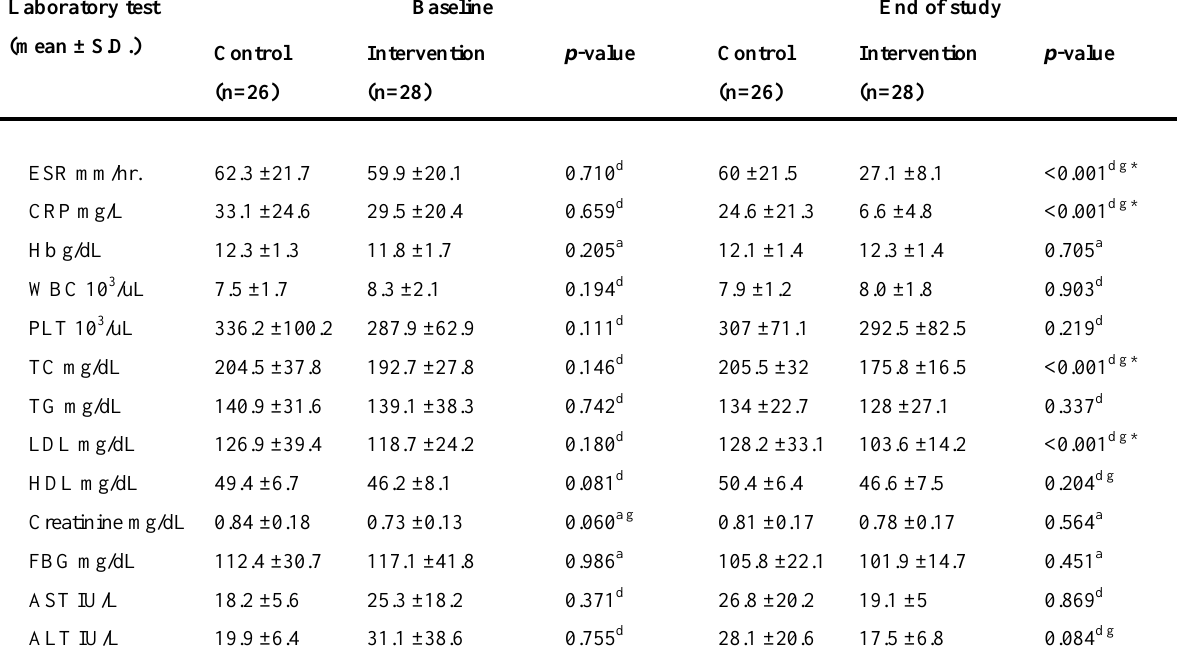
Table 2. Values of laboratory data for the study groups at baseline compared to the end of the study Laboratory test (mean ± S.D.)